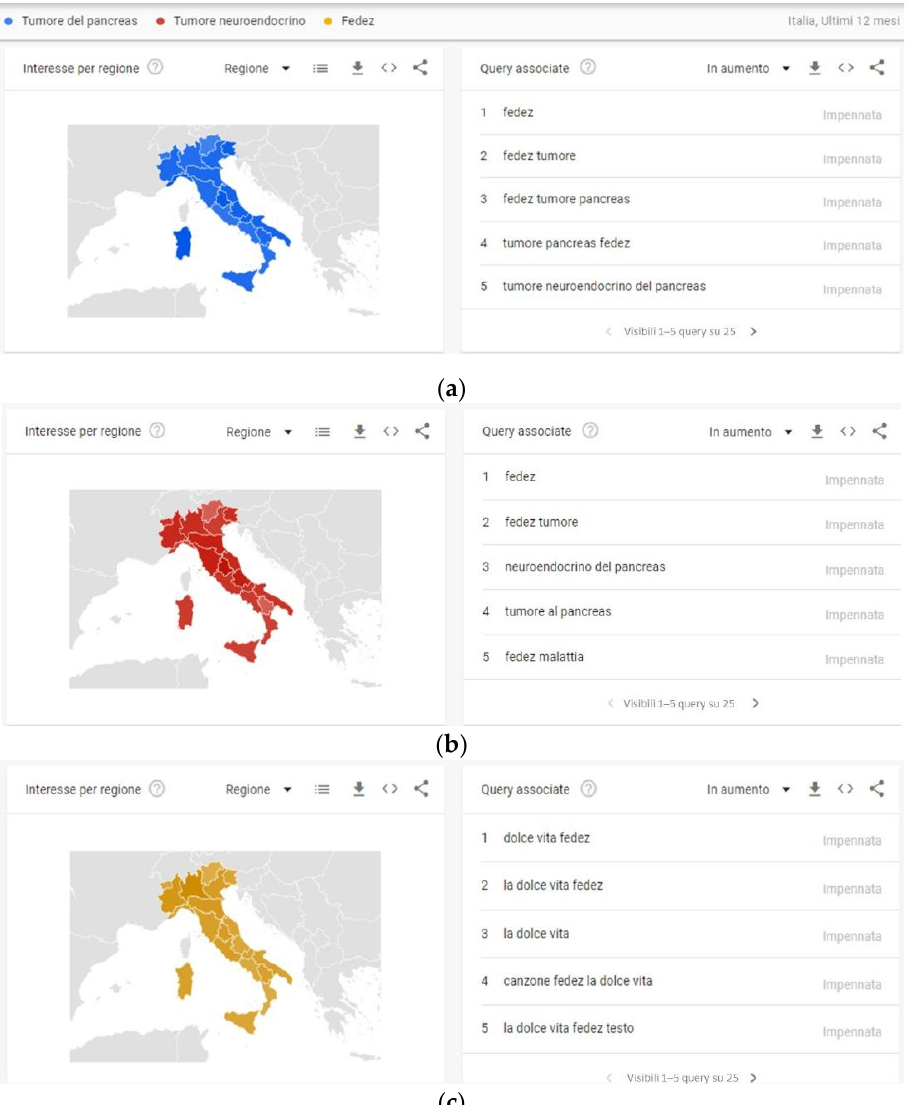
Figure 2. Temporal correlation between Google Trends-based query volumes for “Tumore del Pancreas” (pancreatic cancer), “Tumore neuroendocrino” (neuroendocrine cancer), and “Fedez” in Italy from 5 December 2021 to 20 November 2022, using the option to extract last year’s data on Google Trends.